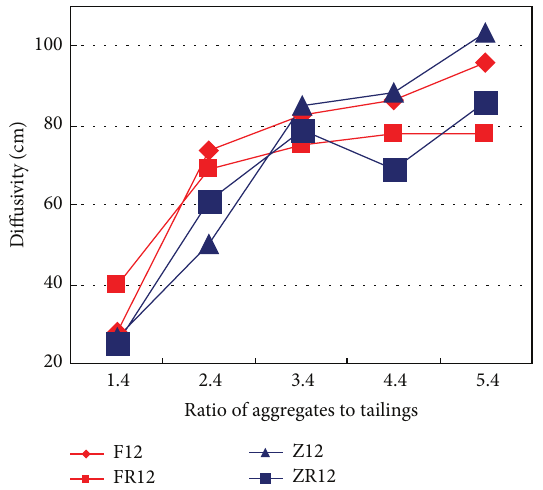
Figure 10: Backfill slurry diffusivity using 12% cement content.